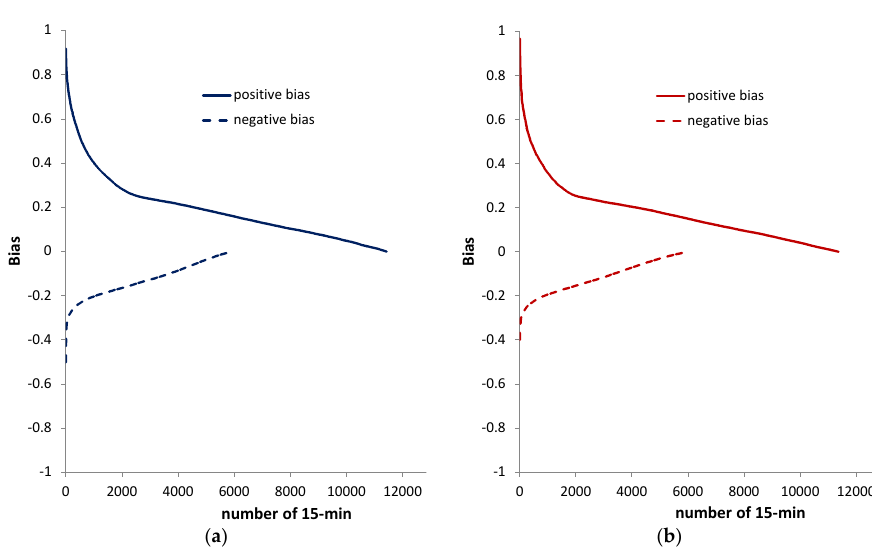
Figure 7. Duration curve of positive and negative bias for the solar irradiance estimated data with respect to measurements for the year 2012. ( a ) Site “Gi”; ( b ) Site “Ma”.